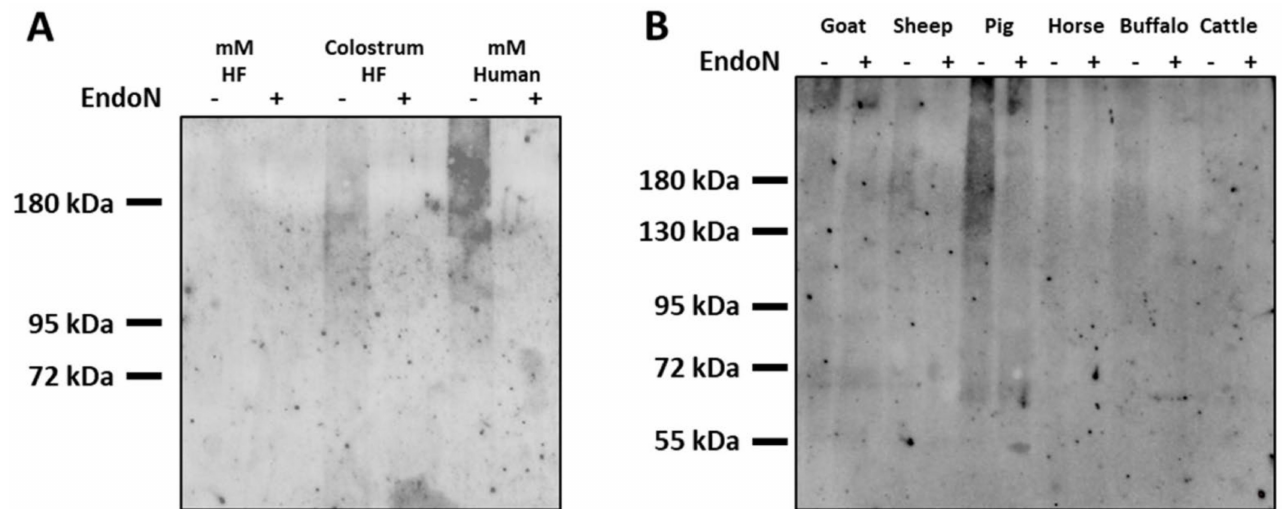
Figure 5. PolySia levels in milk of different farm animals and humans. PolySia was isolated by affinity precipitation and analyzed by Western blotting, as described in Figure 2. ( A ) PolySia from human milk samples was visualized in parallel to eluates from bovine (HF) colostrum and mature milk. ( B ) The mature milk of different farm animals was used for the isolation and subsequent detection of polySia by Western blotting. Pretreatment with endoN served as a negative control. mM = mature